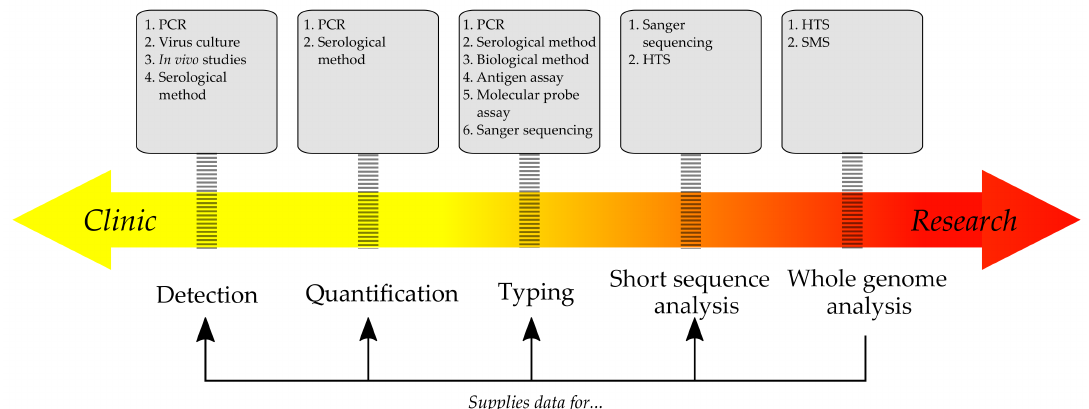
Figure 1. The prevalence of clinical or scientific application depends on the method and the type of data it yields. Classic approaches, like serology and PCR, are quick, but naturally limited to only the known pathogens. More advanced methods, such as HTS, could supply vital data for diagnostics (e.g., optimal target regions for PCR) and further clinical